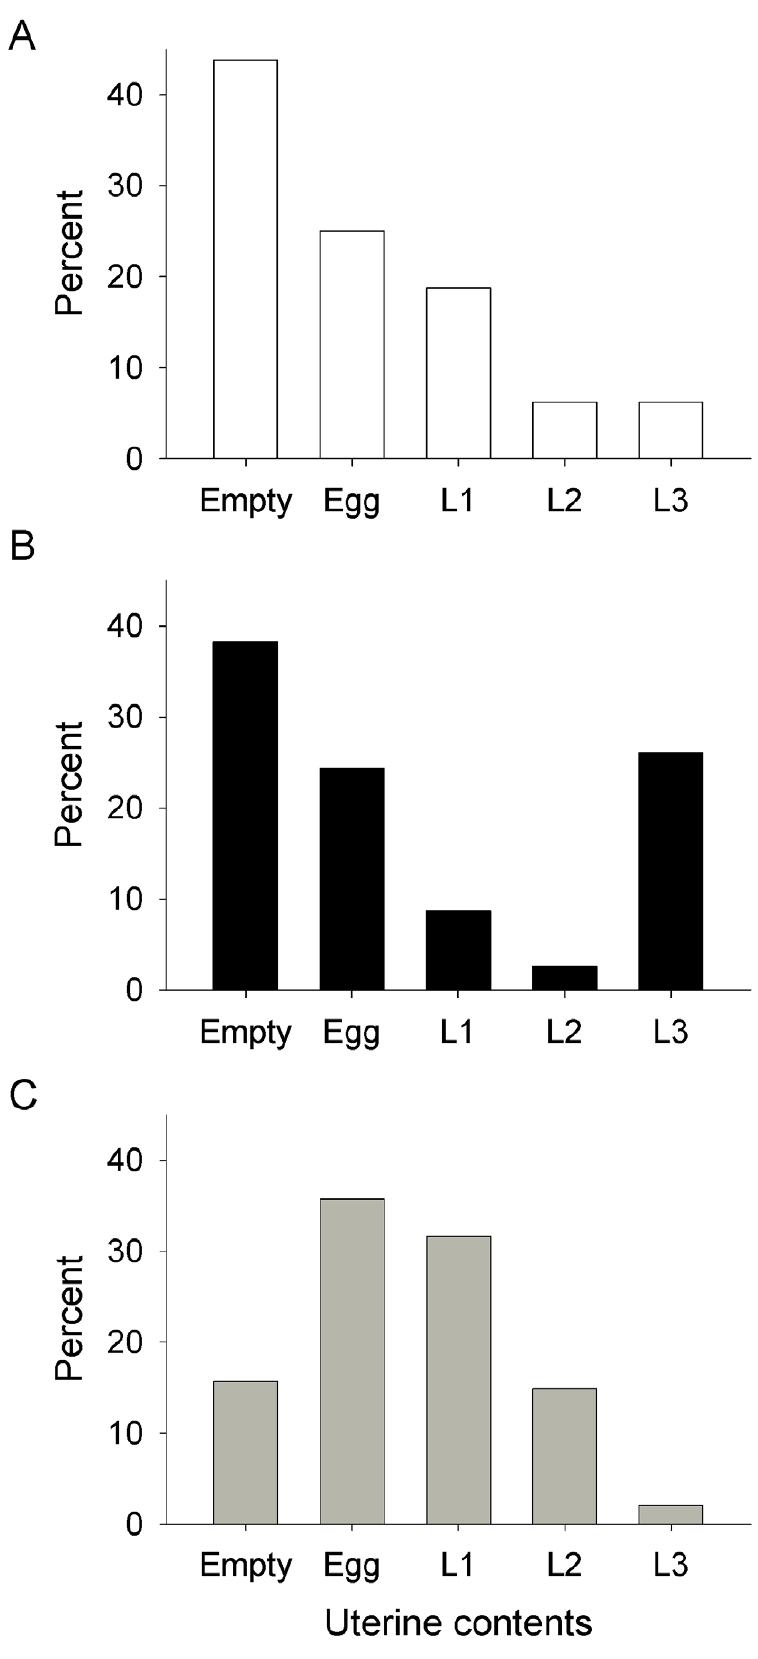
Figure 4. Uterine contents of female G.pallidipes from (A) men, (B) ox and (C) traps. Percent distribution of uterine contents of female G. pallidipes in ovarian categories . 0, from (A) men, (B) ox and (C) traps. Sample sizes of 16, 115 and 1498 for men, ox and traps, respectively. doi:10.1371/journal.pntd.0001791.g004 PLOS Neglected Tropical Diseases |